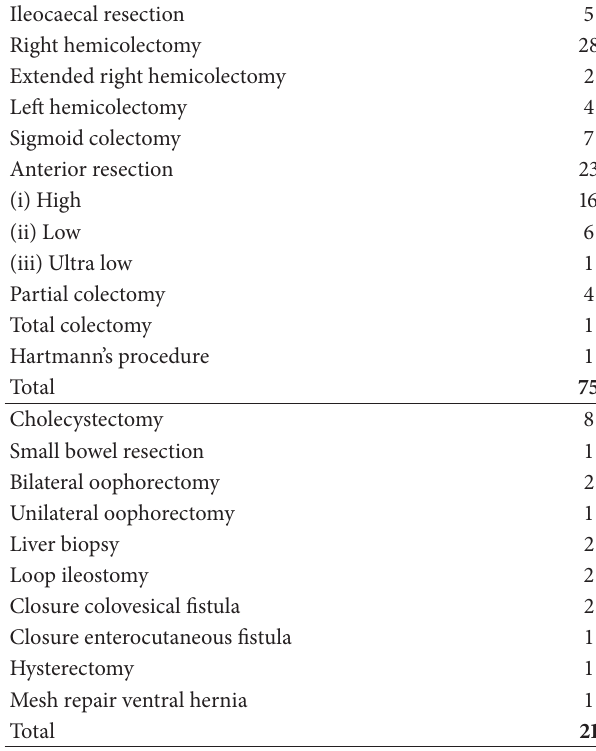
Table 3: Summary of 75 laparoscopic colorectal resections and 21 associated